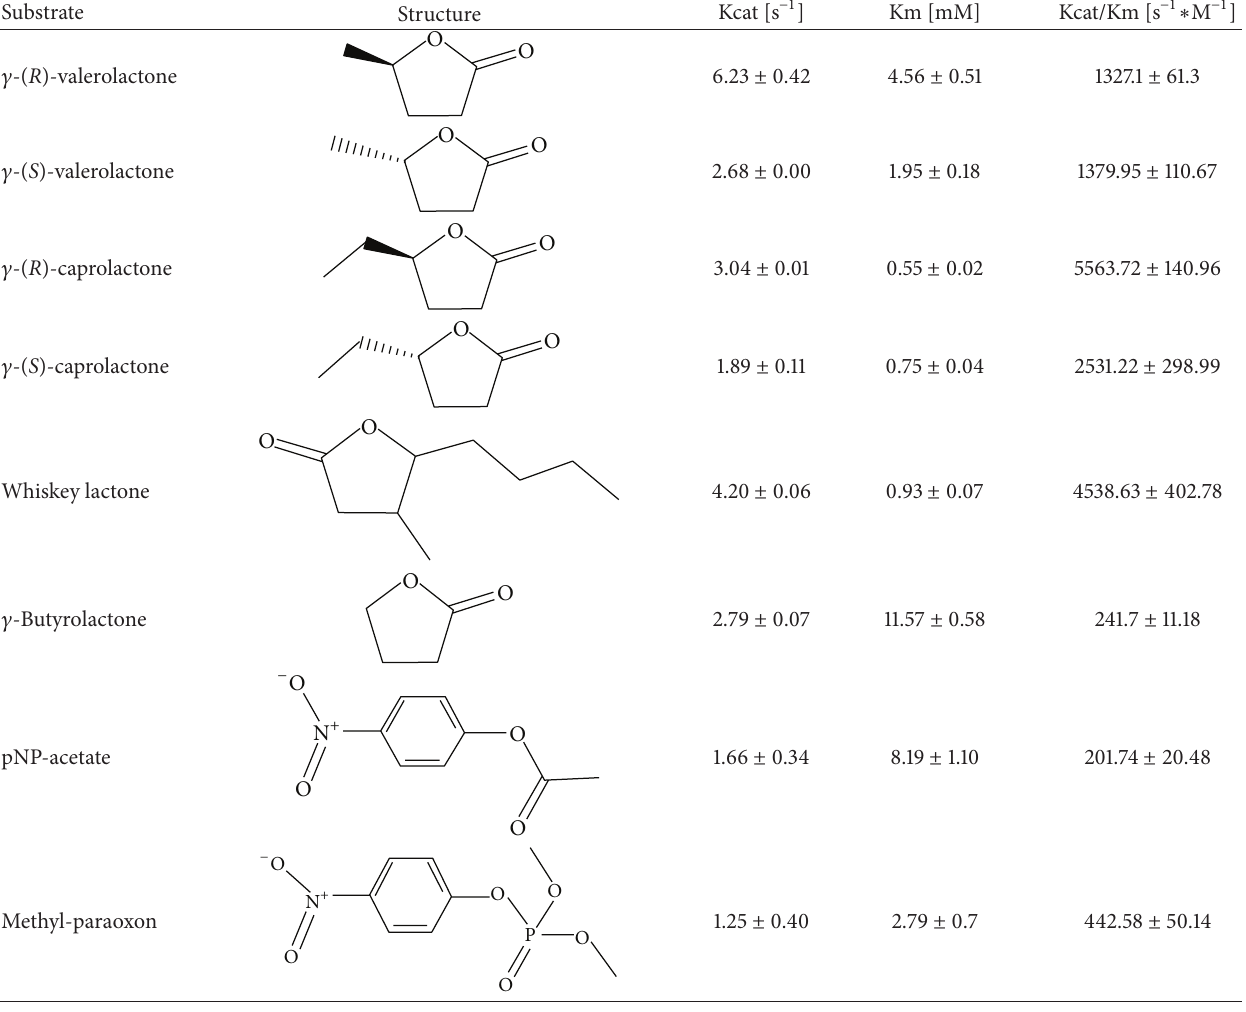
Table 1: The kinetic parameters of the activity of the VmutPLL enzyme with different lactone substrates. Taken from Kallnik et al., 2014 [45].